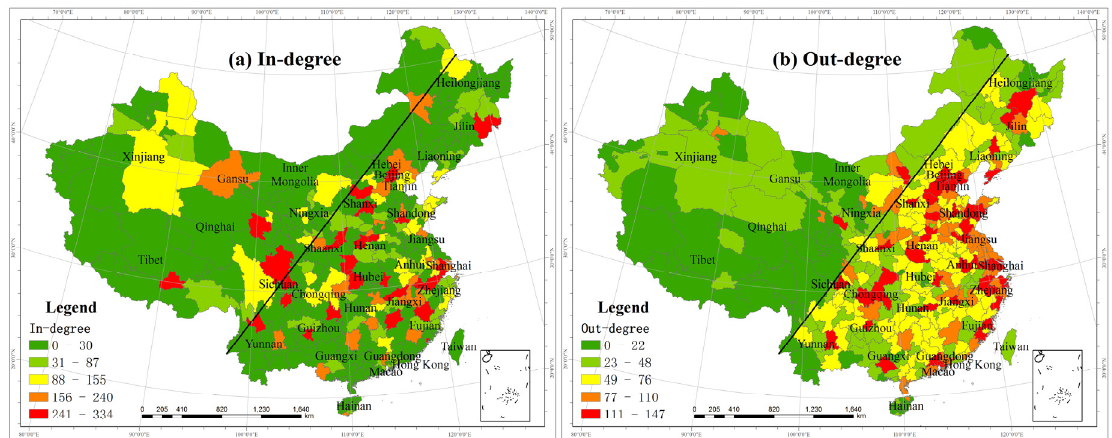
Figure 8. Degree centrality of the tourism information flow network in